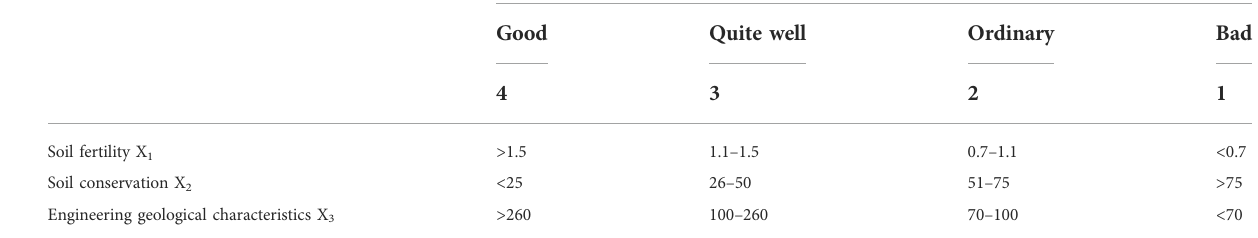
TABLE 5 The factors classi fi cation of land utilization.